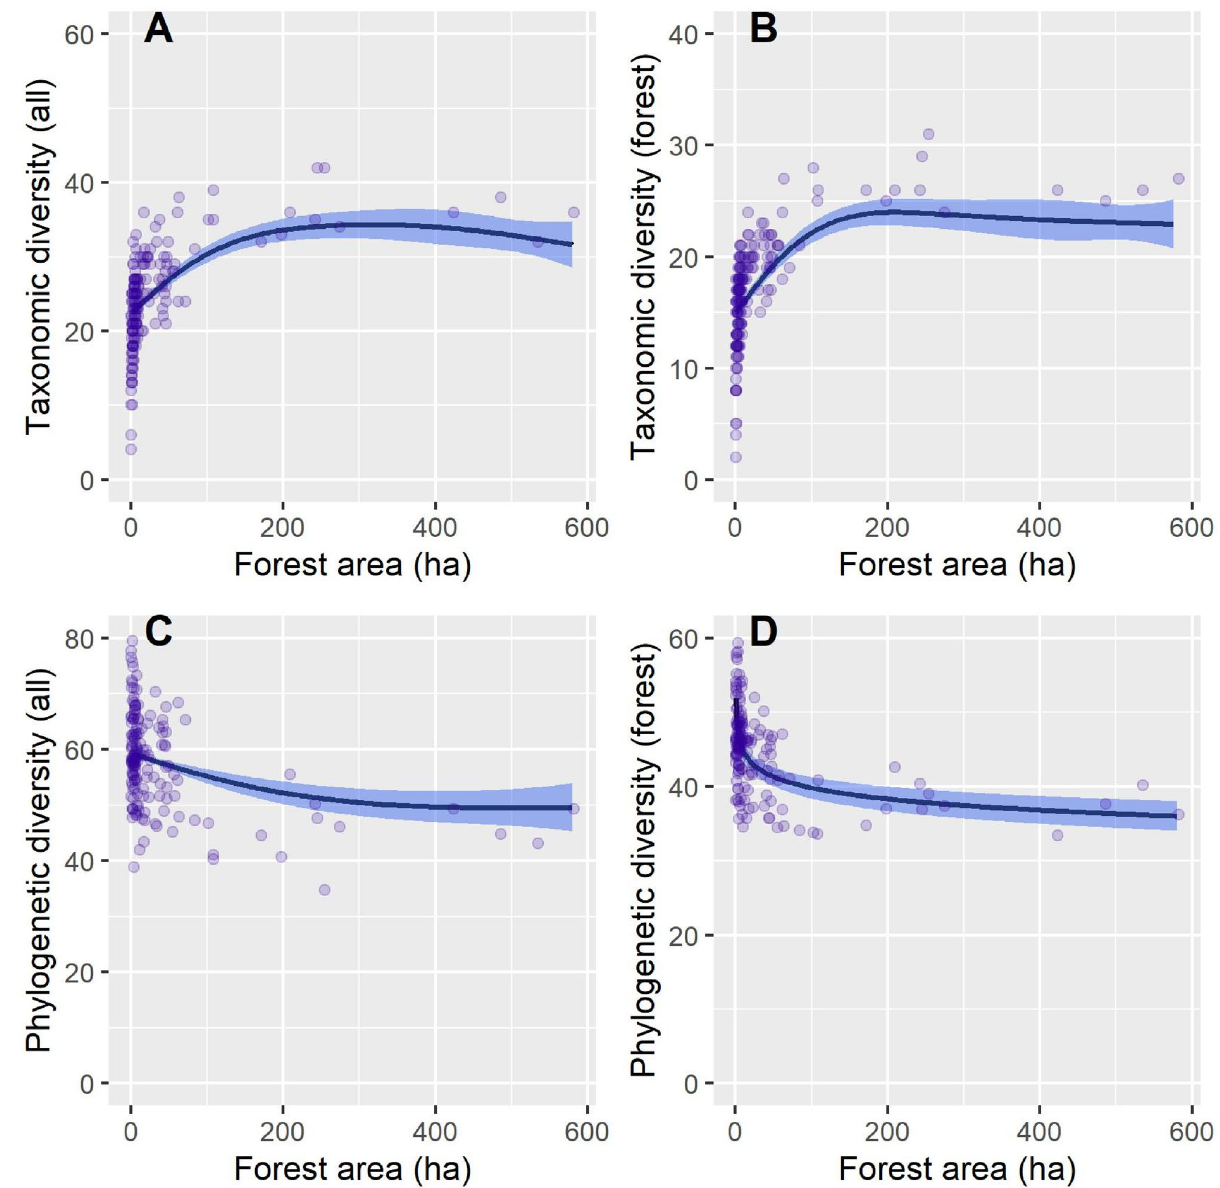
Figure 2. Response curves, derived from General Additive Modelling, showing the relationship between taxonomic and phylogenetic diversity (calculated for all of the bird species and forest specialist group) and forest patch area (in